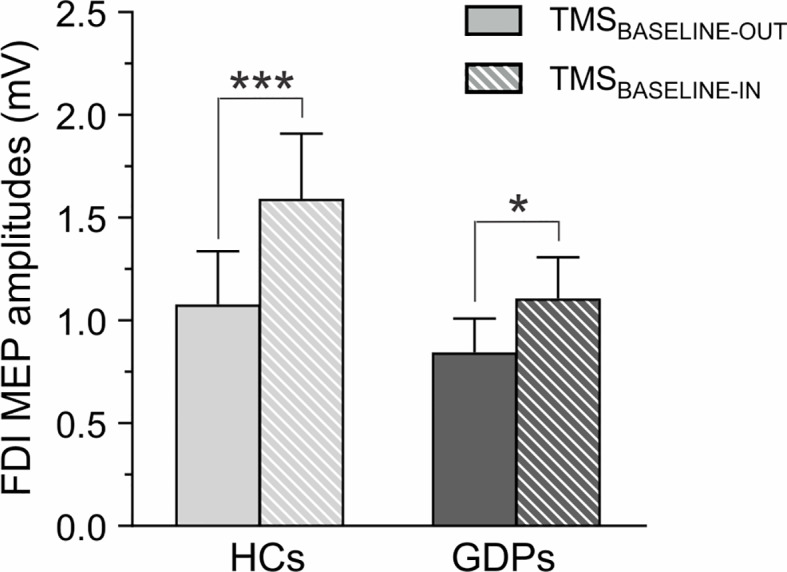
Measures of corticospinal excitability (CSE) at rest. Raw amplitude of motor-evoked potentials (MEPs, in mV) recorded in the FDI at rest, either outside (TMSBASELINE-OUT; open bars) or within (TMSBASELINE-IN; dashed bars) the blocks. MEPs are shown for HCs (light gray) and GDPs (dark gray). Such as revealed by the significant GROUP X TMS-TIMING interaction, the increase in CSE during the task was larger in HCs than in GDPs. *p < 0.05 and ***p < 0.001: significantly different.